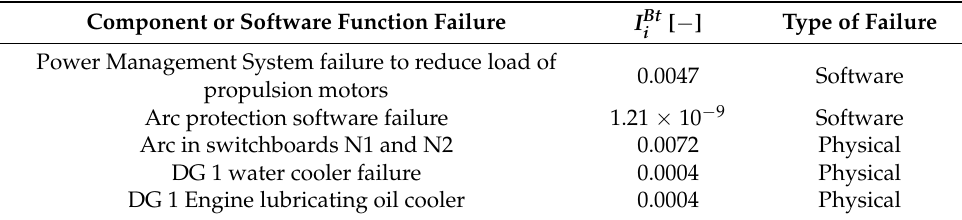
Table 5. Importance measures